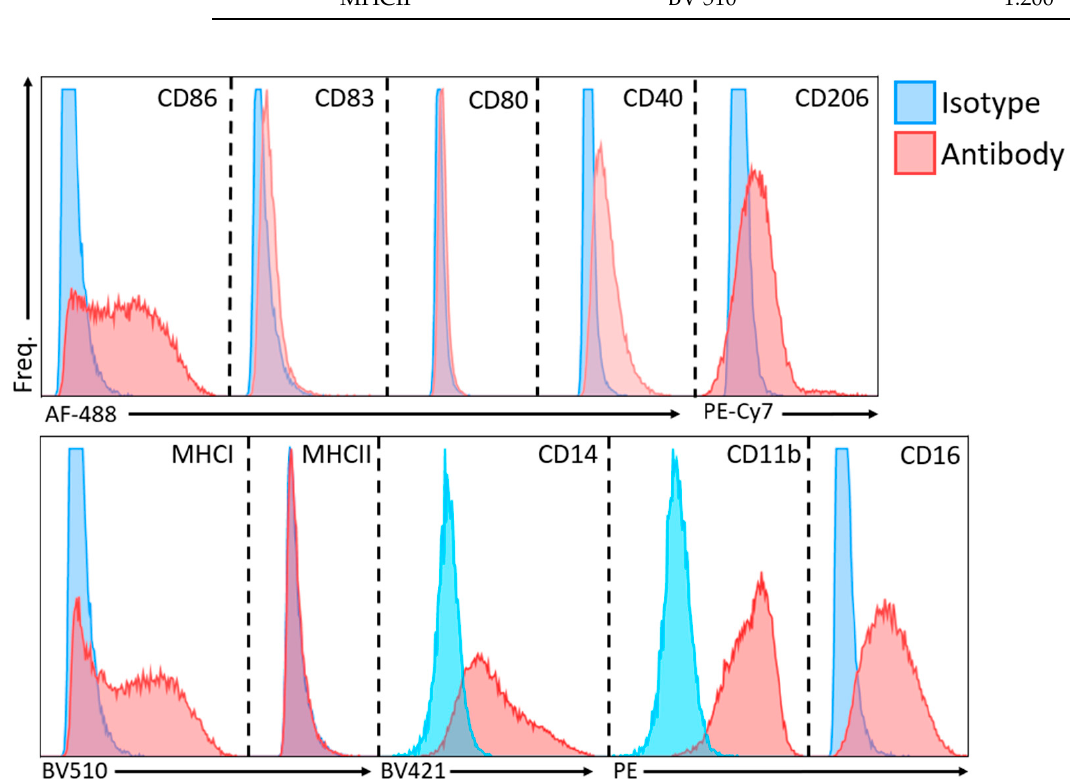
Figure 5. Overlay histograms of isotype controls and sample of interest for flow cytometry. PE, phycoerythrin; AF, Alexa Fluor; PE-Cy7, phycoerythrin-cyanine 7; BV, Brilliant Violet.